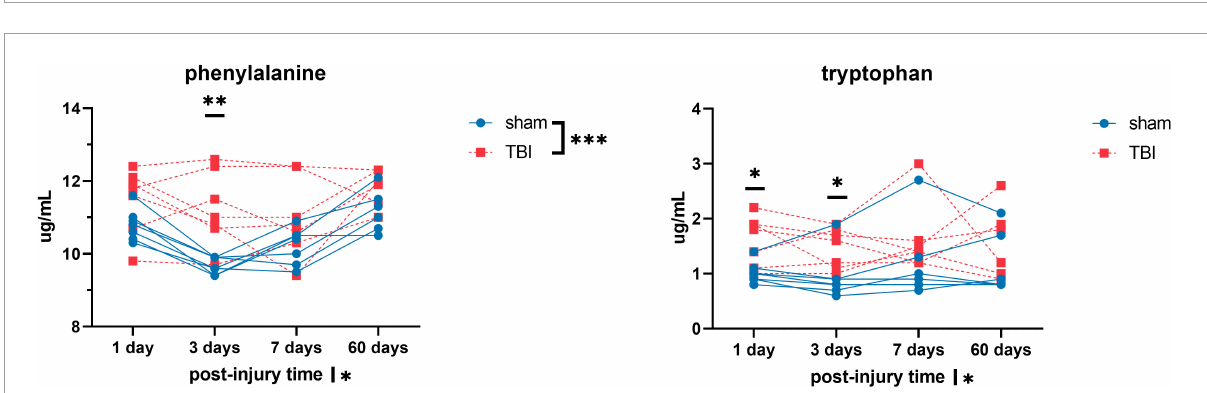
FIGURE3 Plasma levels of amino acids: phenylalanine and tryptophan of sham and TBI animals at day one, three, seven, and sixty post-procedure. Asterisks ( ∗ ) next to sham/TBI legends, post-injury time axis label, and interaction effect indicated statistically significant group, post-injury time, and group × post-injury time effects, respectively, in ANOVA. ∗ On the graph at each timepoint indicated significant difference between TBI and sham animals at each timepoint, Fisher’s Least Squared Difference post-hoc test. ∗ P -value < 0.05, ∗∗ P -value < 0.01, ∗∗∗ P -value <